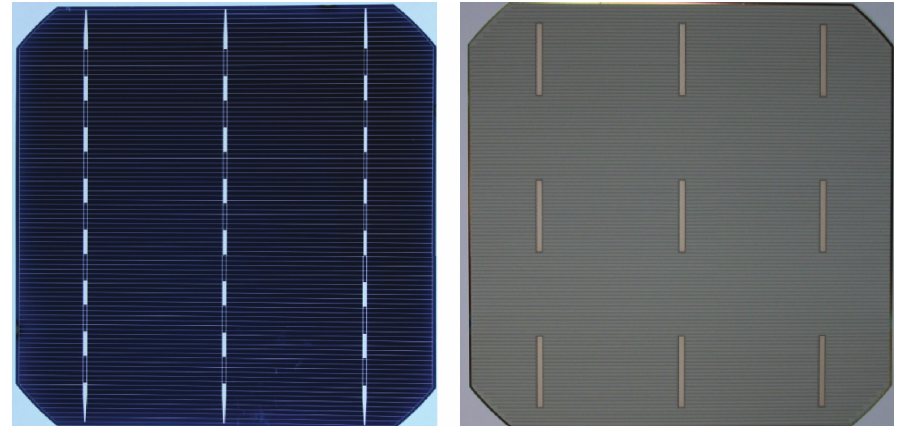
Figure 1: The experimental sample of Cz-Si solar cells with PERC structure.